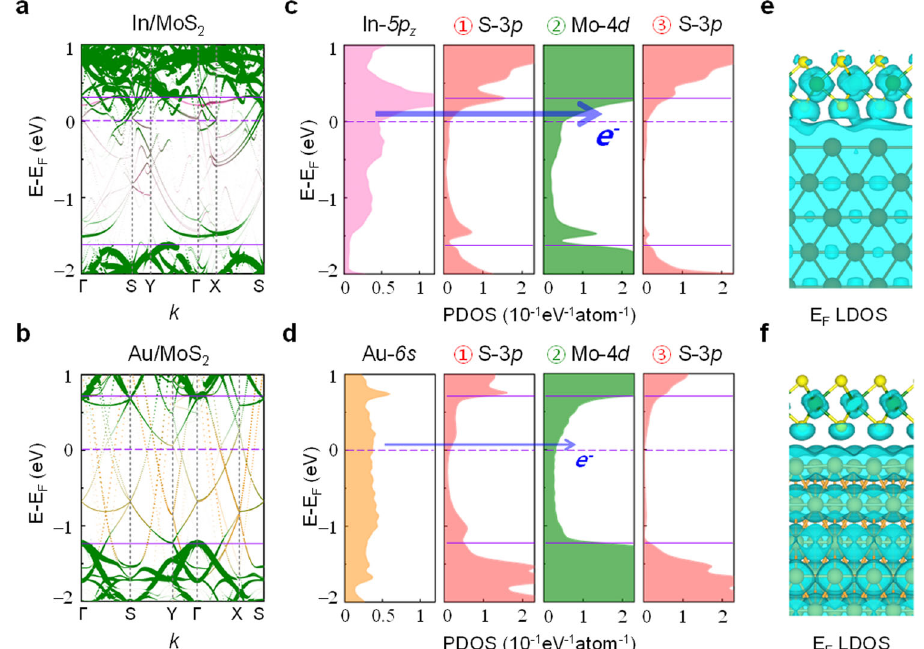
Fig. 8 Atomistic origins of the fi eld emission-dominated charge transport across In/MoS 2 contacts. Projected band structures of the Mo- 4d states (green- fi lled circle) for the a In/MoS 2 and b Au/MoS 2 interfaces. Shown together in c and d are the In-5 p z (pink fi lled circles) and Au- 6s states (orange fi lled circles) contributions, respectively. The circle size is proportional to the weight of the projection of the wavefunctions. The PDOS of the In-5 p z (top left panel) and Au- 6s (bottom left panel), ① metal-contacting S- 3p (second panels), ② Mo- 4d (third panels), and ③ outer S- 3p (fourth panels) orbitals. In the second, third, and fourth panels, the upper and lower solid lines indicate the MoS 2 CBM and VBM levels, respectively. The arrows schematically show that the charge transport across the In/MoS 2 contact is much more ef fi cient than that across the Au/MoS 2 counterpart, and the Ohmic-like charge transport is mediated by the large in-gap states formed around E F of the In/MoS 2 interface. The local DOS in the range between E F and E F + 0.2 eV overlaid over the e In/MoS 2 and f Au/MoS 2 interface models. The iso-surface level is 2.5 × 10 − 4 states eV − 1 Å − 3